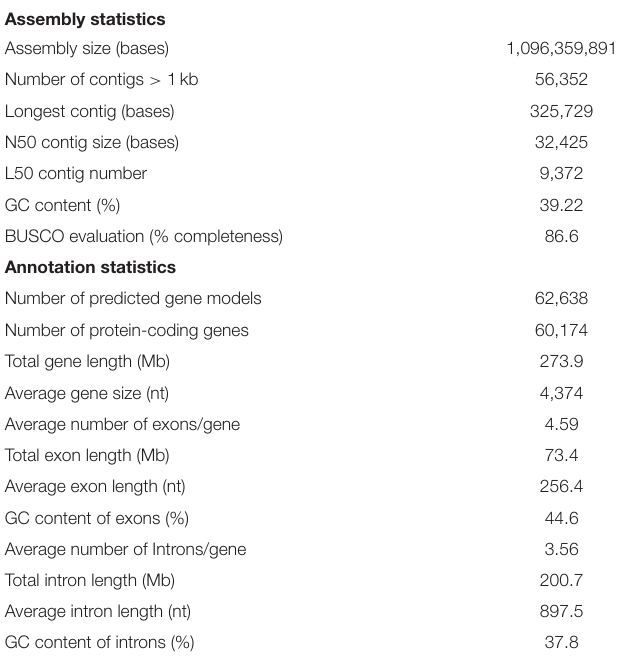
TABLE 1 | Assembly and annotation statistics for P. sinensis